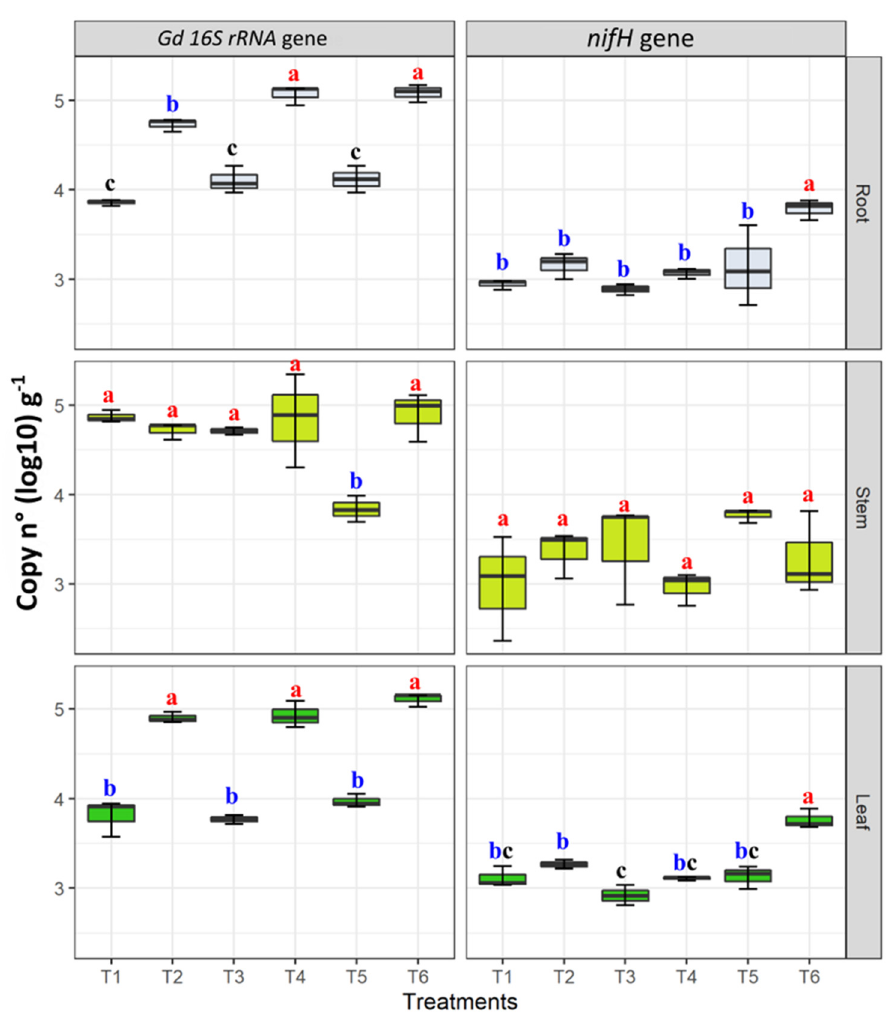
Figure 7. Quantification of G. diazotrophicus (Gd) 16S rRNA and nifH gene copies in samples of maize plant tissues (leaves, stems, and roots) grown plants under water and nitrogen stress treatments, applied individually and in combination (T1-T6). Gene abundance was copy numbers log 10 per gram of fresh plant tissue (copy n° (Log 10)·g − 1 ). Boxplots show the third quartile and first quartile (box edges), median (middle line) and range of the data (whiskers). Each boxplot represents the average of three samples. Boxplots having the same letters are significantly similar according to the Tukey HSD test at p < 0.05.